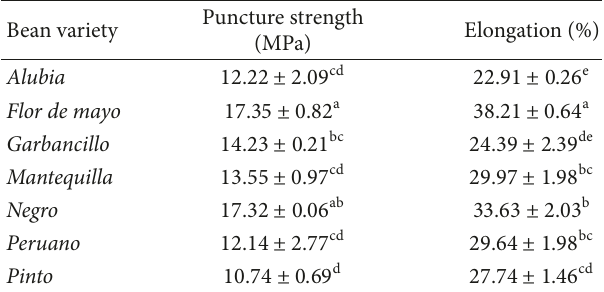
Table 2: Mechanical properties of the tested proteinaceous edible films obtained from the studied bean varieties a